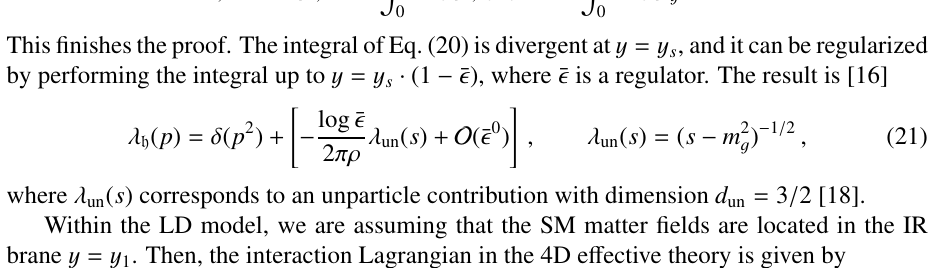
The spectral function in the LD model, defined as in Eq. (10), is related to a disconti- nuity of the Green’s function at the branch cut s ∈ [ m 2